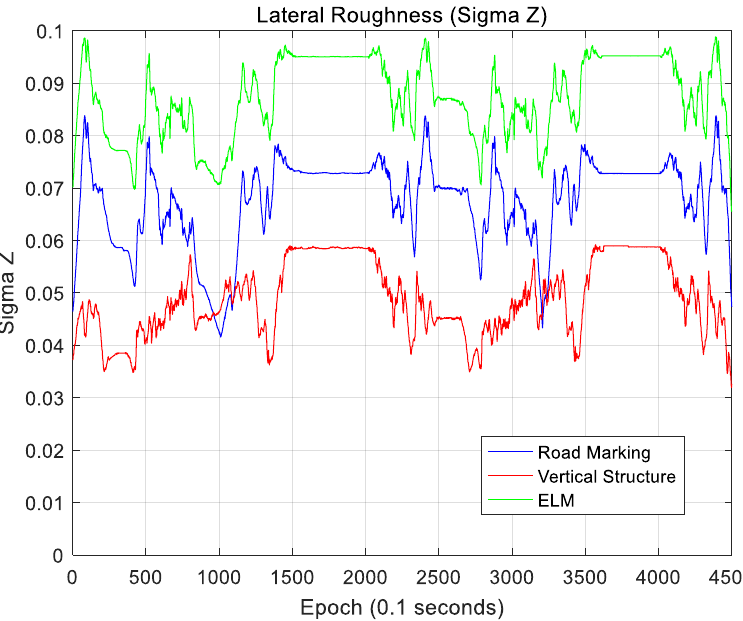
Figure 37. Lateral roughness (Sigma-Z).